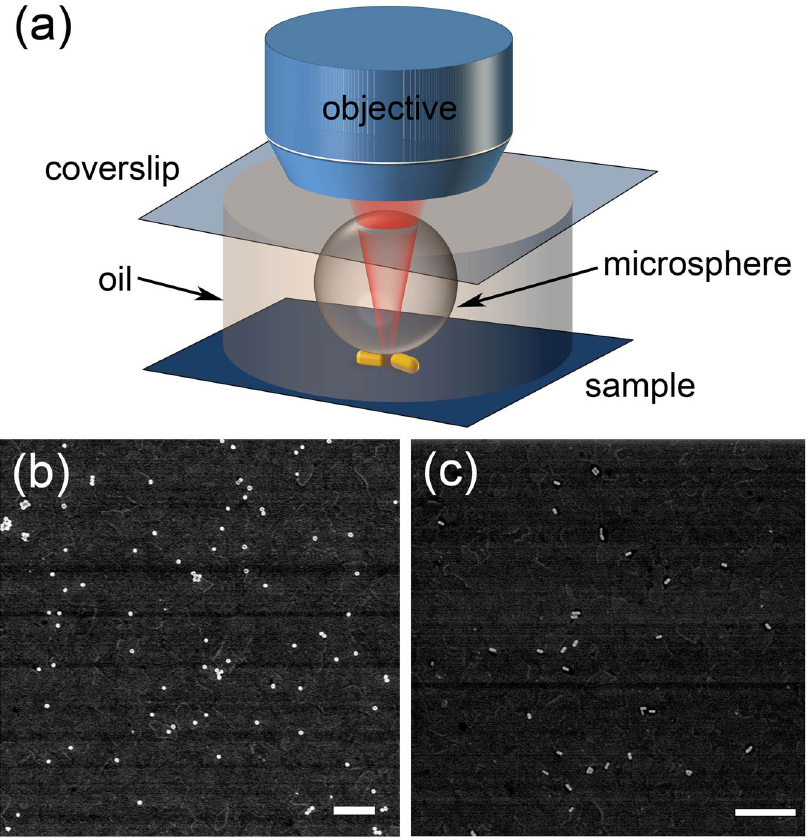
Figure 1. ( a ) Schematic of experimental setup. The microspheres are BaTiO 3 with refractive index larger than 1.93. Drawing is not to scale. SEM images of gold nanospheres ( b ) and gold nanorods ( c ) samples. Scale bars: 1000